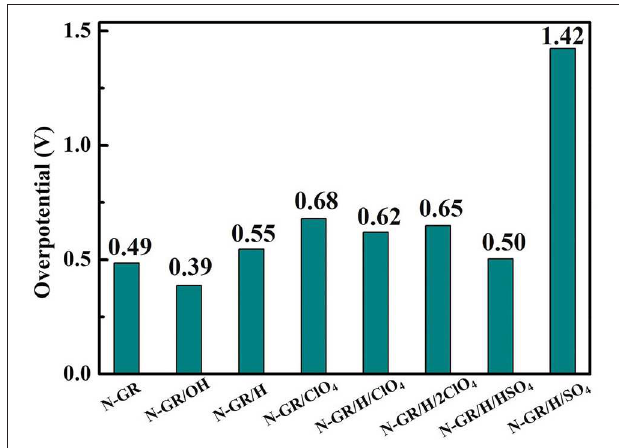
FIGURE 7 | The overpotential of ORR on N-doped graphene nanoribbons with different adsorbed